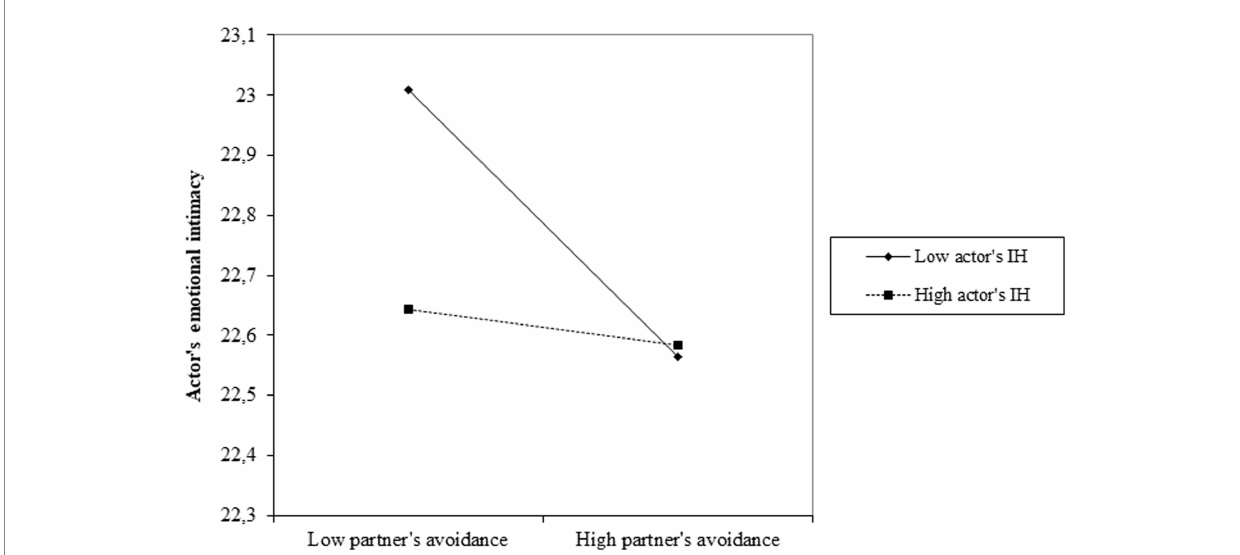
FIGURE 1 The association of partner’s attachment avoidance with actor’s emotional intimacy as a function of actor’s internalized homonegativity (IH).